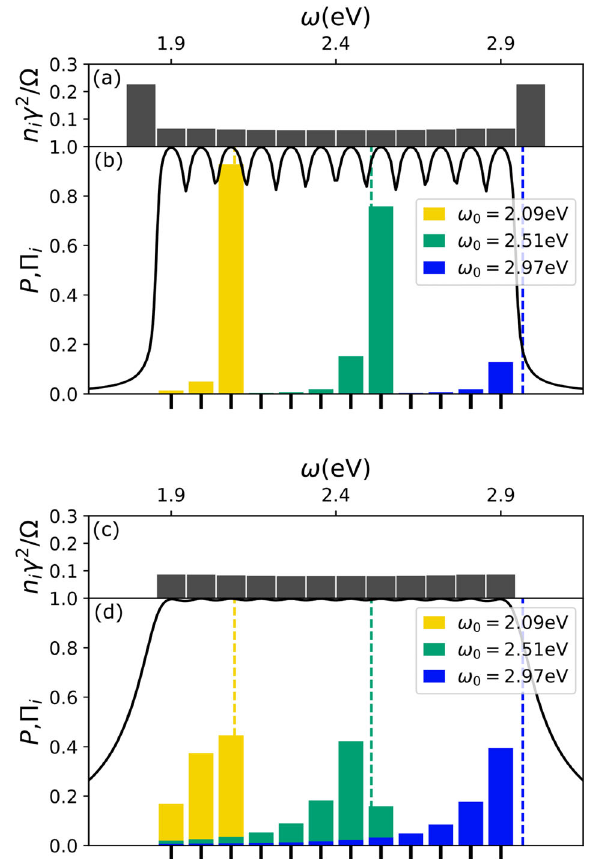
Fig. 5 Performance of photodetectors without cooperativity. Performance of detectors comprising independent subsystems interacting with the photon in sequence, starting from the lowest frequency bin. Under these conditions the nonabsorbing lowest and highest frequency subsystems have no impact on the detector performance and are omitted. a , b The subsystem compositions are the same as the optimal detector when cooperativity is included. c , d The subsystems are calibrated to satisfy the condition of ef fi ciency ≥ 99% over the detector frequency range. In b , d the colored bars indicate the probability of a photon of that frequency ω 0 being detected at each bin, the characteristic frequencies of which are marked by the x-axis